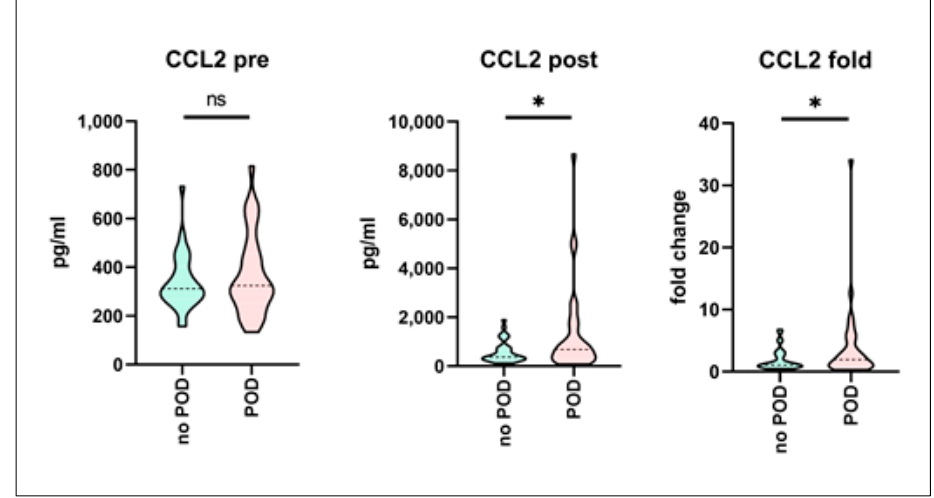
Figure 3. Pre- and postoperative serum biomarker profiling (no-POD and POD) following propensity score matching. Serum was sampled prior to and following surgery from a mixed cohort of consecutively recruited elective non-cardiac as well as cardiac surgery patients. Biomarker profiling was performed using the multiplex array technique. Development of postoperative delirium (POD) was assessed, and POD-positive patients were matched with respect to no-POD controls using propensity score matching. Figure shows results for the CCL2 (CC-chemokine Ligand 2) serum levels. Data are given as median values (black dashed line) with 25th and 75th percentile (white dashed lines) and were compared using Wilcoxon rank-sum test. no POD: n = 33, POD: n = 33. ns = not significant, * p <0.05.